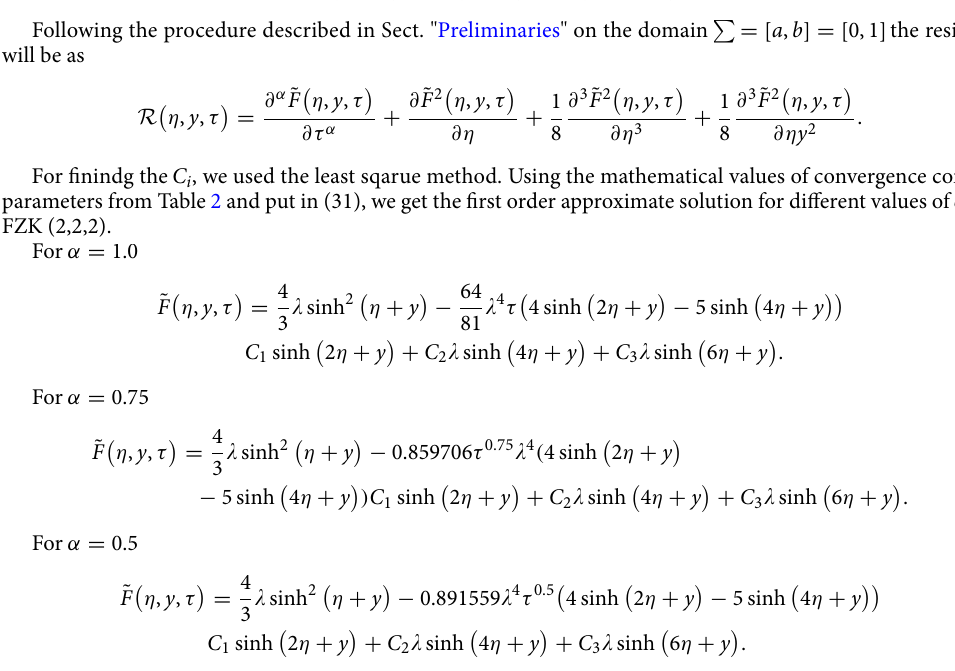
By adding (26) and (31), we obtain the first order approximate result for FZK(2,2,2) by the succeeding appearance,